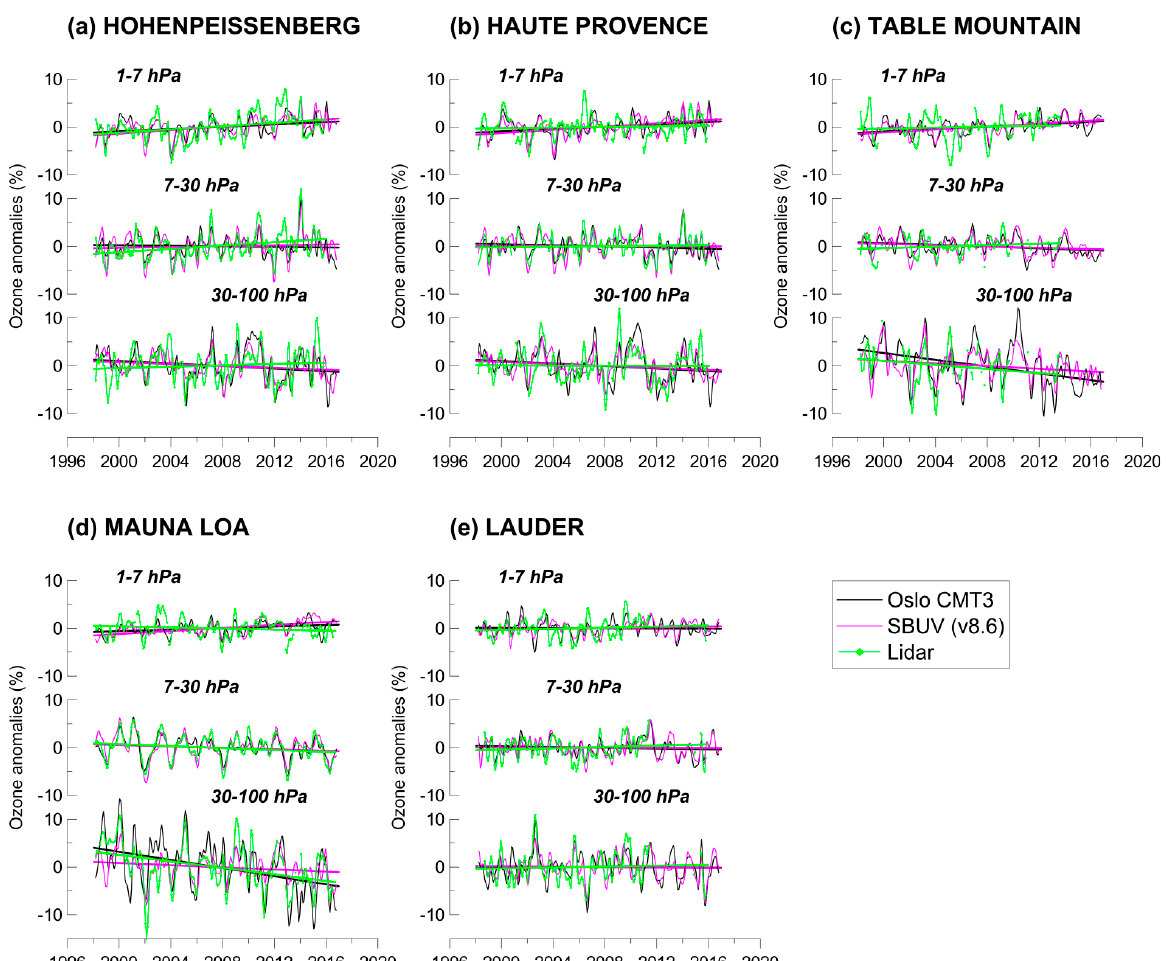
Figure 1. Ozone trends in the upper stratosphere (1–7 hPa), middle stratosphere (7–30 hPa) and lower stratosphere (30–100 hPa), from lidar measurements, SBUV (v8.6) satellite data and Oslo CTM3 simulations over ( a ) Hohenpeissenberg, ( b ) Haute Provence and ( c ) Table Mountain (upper panel), and over ( d ) Mauna Loa and ( e ) Lauder (lower panel). Seasonal and natural proxies are removed. For lidars, the upper stratospheric layers are confined between 3 and 7 hPa. Figure 2 summarizes the comparison of model simulations (Oslo CTM3 and EMAC CCM) with satellite and lidar residuals averaged at all stations under study. The figure shows results for the upper, middle and lower stratosphere for the period of 1998 to 2016. The correlation coefficients (Pearson product-moment correlation), R, between the four datasets are shown in Table 3 for the five stations’ mean. Results for each station separately are provided in Supplementary Tables S1–S5. Statistical significance of R was determined by using the t-test formula for the correlation coefficient, with n-2 degrees of freedom, as by Zerefos et al. [7]. All R are found to be statistically significant at the 99% confidence level or greater. There are higher correlations at some stations, and lower at others, but the general picture of correlations is given in Table 3.